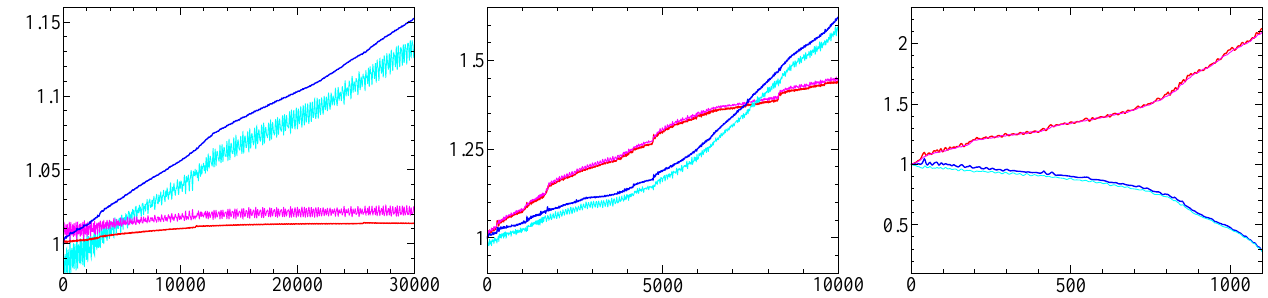
Fig. 2. Time variation of µ ⊥ (red) and T ⊥ (magenta), and also of µ k (blue) and T k (cyan), at fixed β = 0 . 3 and three scale separations (from the blue series of Fig. 1) d i /l f = 0 . 020 (left), d i /l f = 0 . 080 (middle), and d i /l f = 0 . 16 (right).